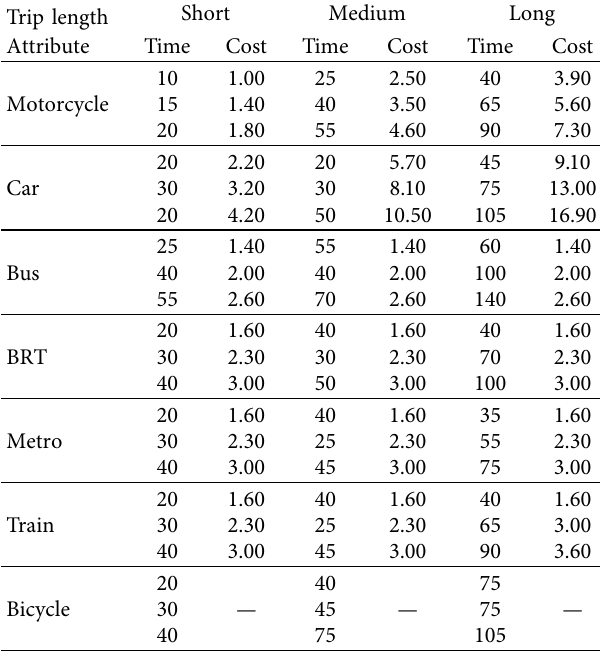
Table 1: Travel time and cost levels in the SP